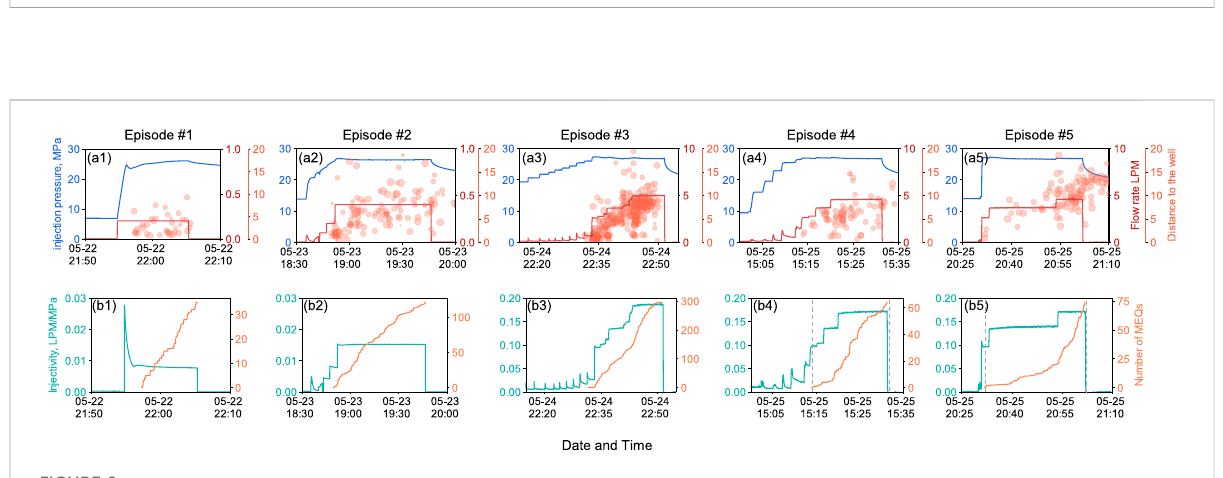
FIGURE 2 Seismicandinjectioninformationofthecollabstimulationexperiment (A1 – A5) showstheinjectionhistoryofthe fi vestimulationepisodes(blue line shows wellhead pressure and red line shows the fl ow rate) and the distance from MEQs to the injection well (orange symbols). Symbol sizes represent the MEQ magnitude. (B1 – B5) shows the ground truth of injectivity history (light green lines) and the cumulative number of MEQs that occurred (orange line) of the fi ve stimulation episodes, respectively. The dashed line shows the periods from the fi rst MEQ which happened to well shut-in during episodes #4 (b4) and #5